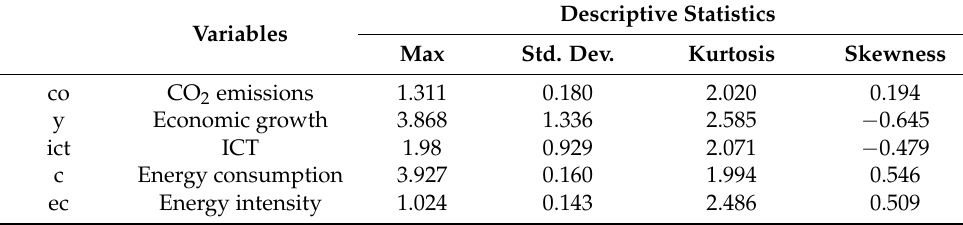
Table 3. Descriptive